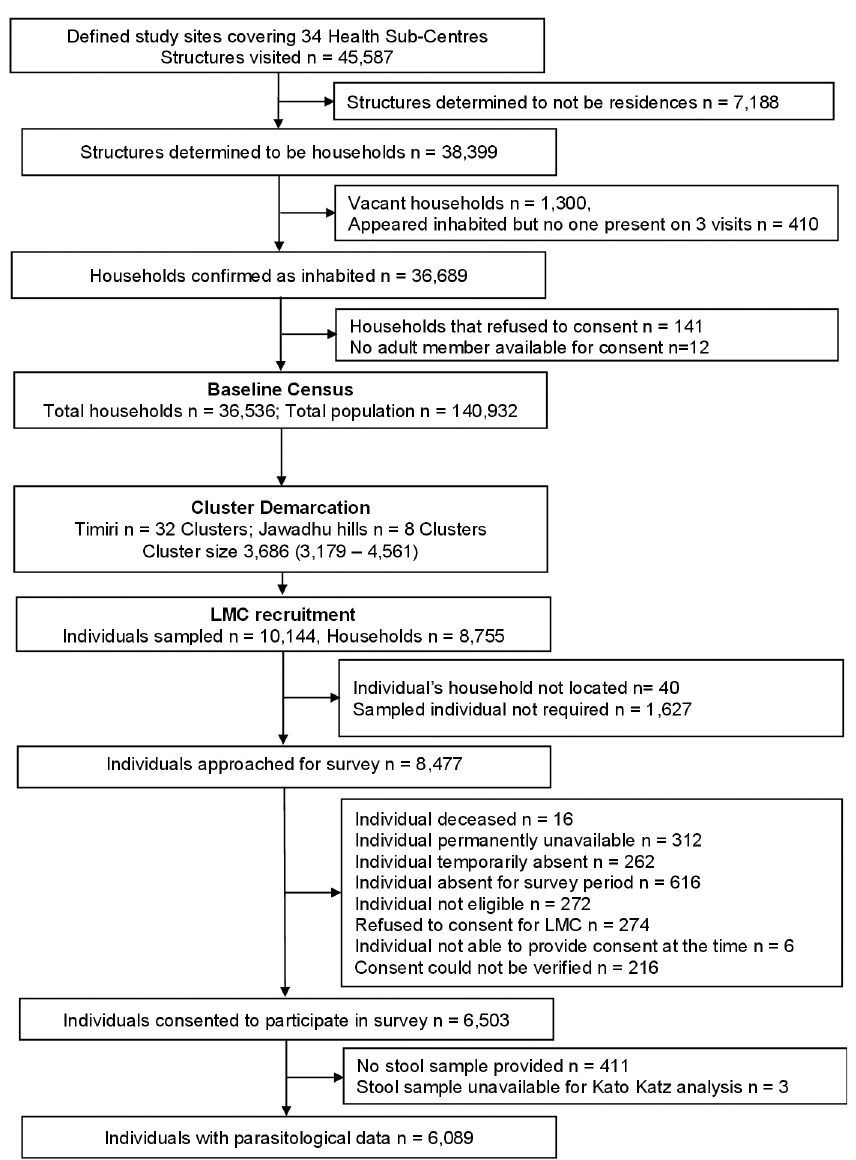
Fig 2. Flow chart of activities during the baseline census and recruitment of the longitudinal monitoring cohort (October 2017- February 2018) Footnote: “Not required” refers to the number of individuals in the ranked, age- stratified, cluster-specific reserve/replacement lists generated who were not approached as the cohort sample size was achieved in the